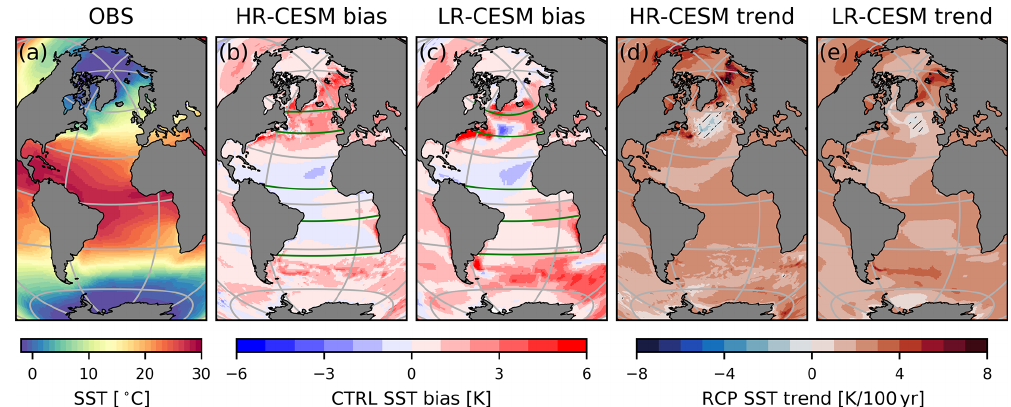
Figure 1. The sea surface temperature (SST) from the HadISST 1990–2019 observations (a) , the SST bias of the HR-CESM (b) and LR- CESM (c) CTRL simulations, and the linear trends of the HR-CESM (d) and LR-CESM (e) RCP climate change scenarios. Hatched areas in the trend maps are not significant at the 5% level. The Lambert azimuthal projection of these and subsequent maps is an equal-area projection, and gray parallels (meridians) are drawn every 30 ◦ (60 ◦ ). The green lines (b, c) show transects in the tripolar 0.1 ◦ and dipolar 1 ◦ POP2 model grid at 34, 10 ◦ S, 10 ◦ N, and approximately 45 and 60 ◦ N. This northernmost meridional boundary differs from the 60 ◦ N parallel because of the curvilinear grids and is chosen to lie south of the Hudson Strait.